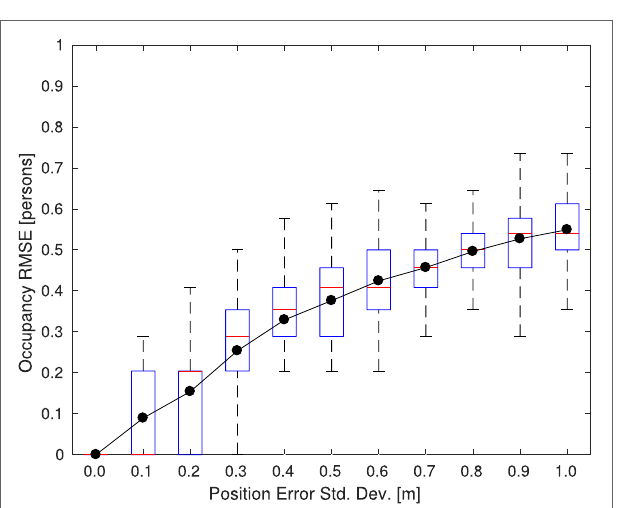
FIGURE 11 | The occupancy count RMSE using estimated footstep assignment in the crossing